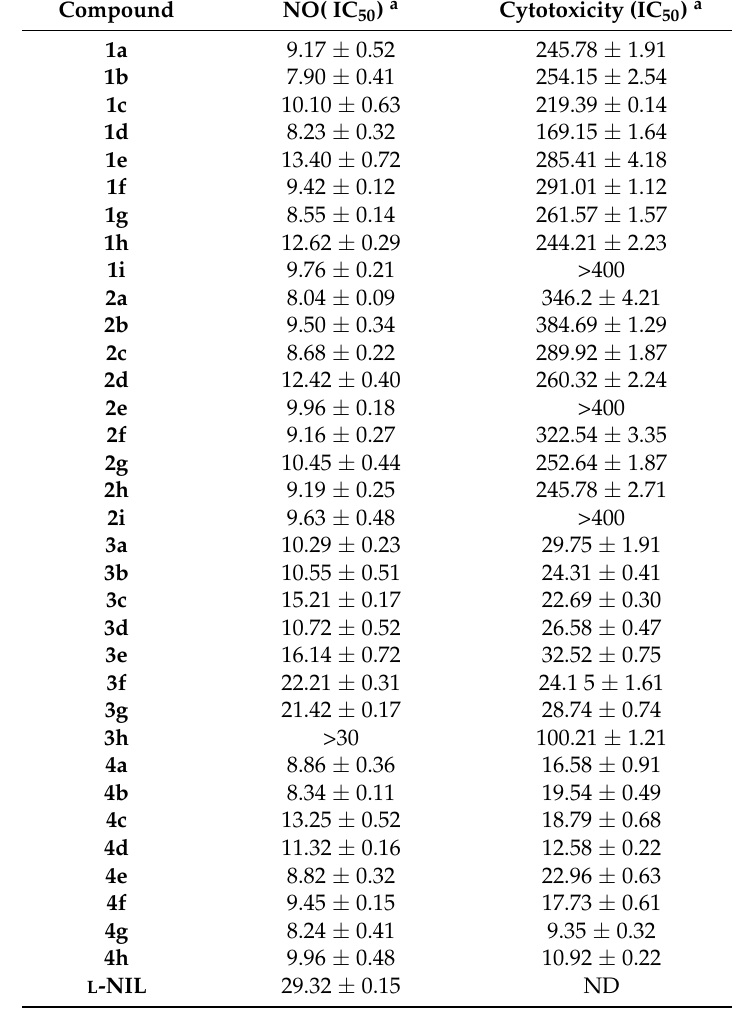
Table 3. IC 50 ( µ M) for nitric oxide production and cell viability of final target